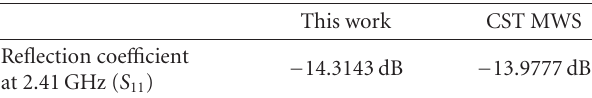
Table 1: Reflection coe ffi cient at the operation frequency. This work CST MWS Reflection coe ffi cient − 14.3143 dB − 13.9777 at 2.41 GHz ( S 11 )